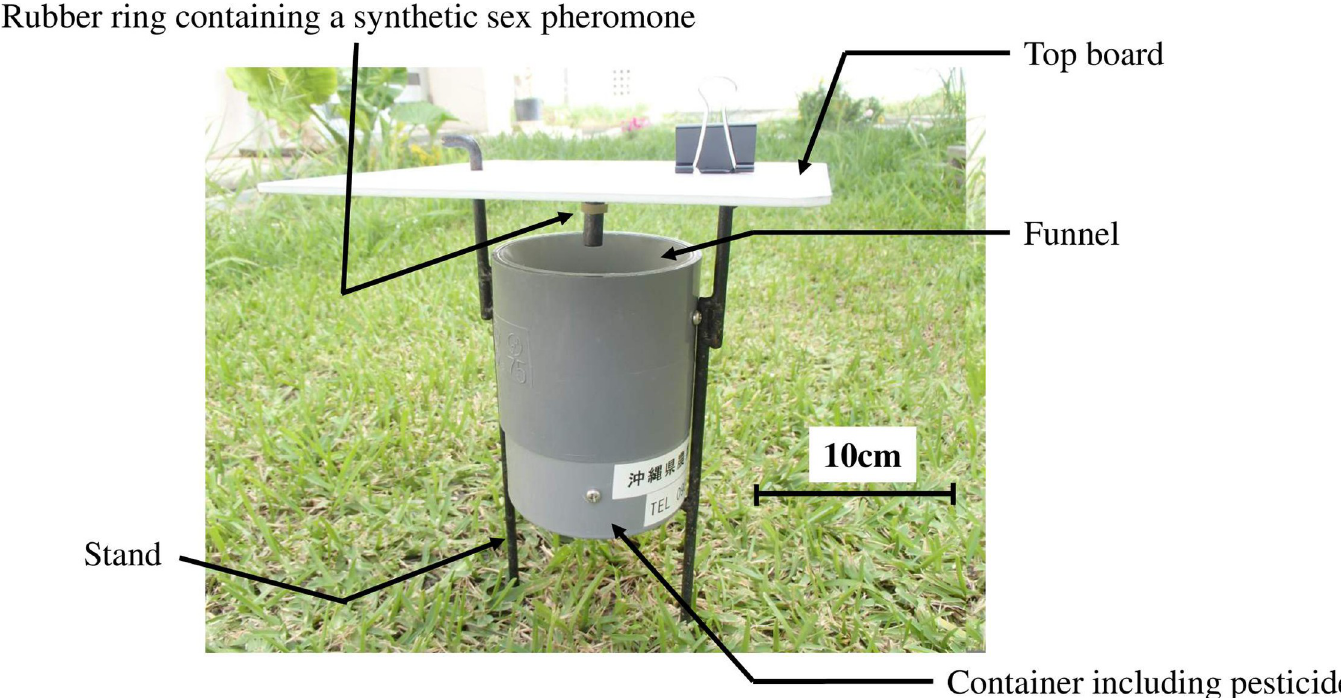
Fig 3. Cylinder-type sex pheromone trap used after April 1998. Traps were fitted with a rubber septum or ring containing 0.1 mg of a synthetic pheromone as an attractant. Insecticide (DDVP) was added to prevent the escape of the trapped insects.